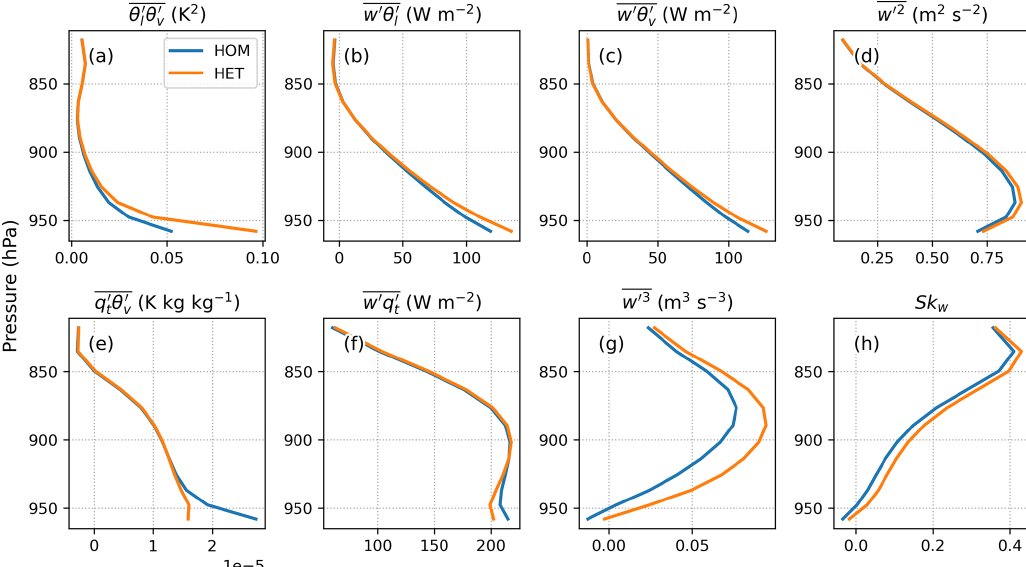
θ (cid:48) v , (b) turbulent flux of liquid water potential temperature l